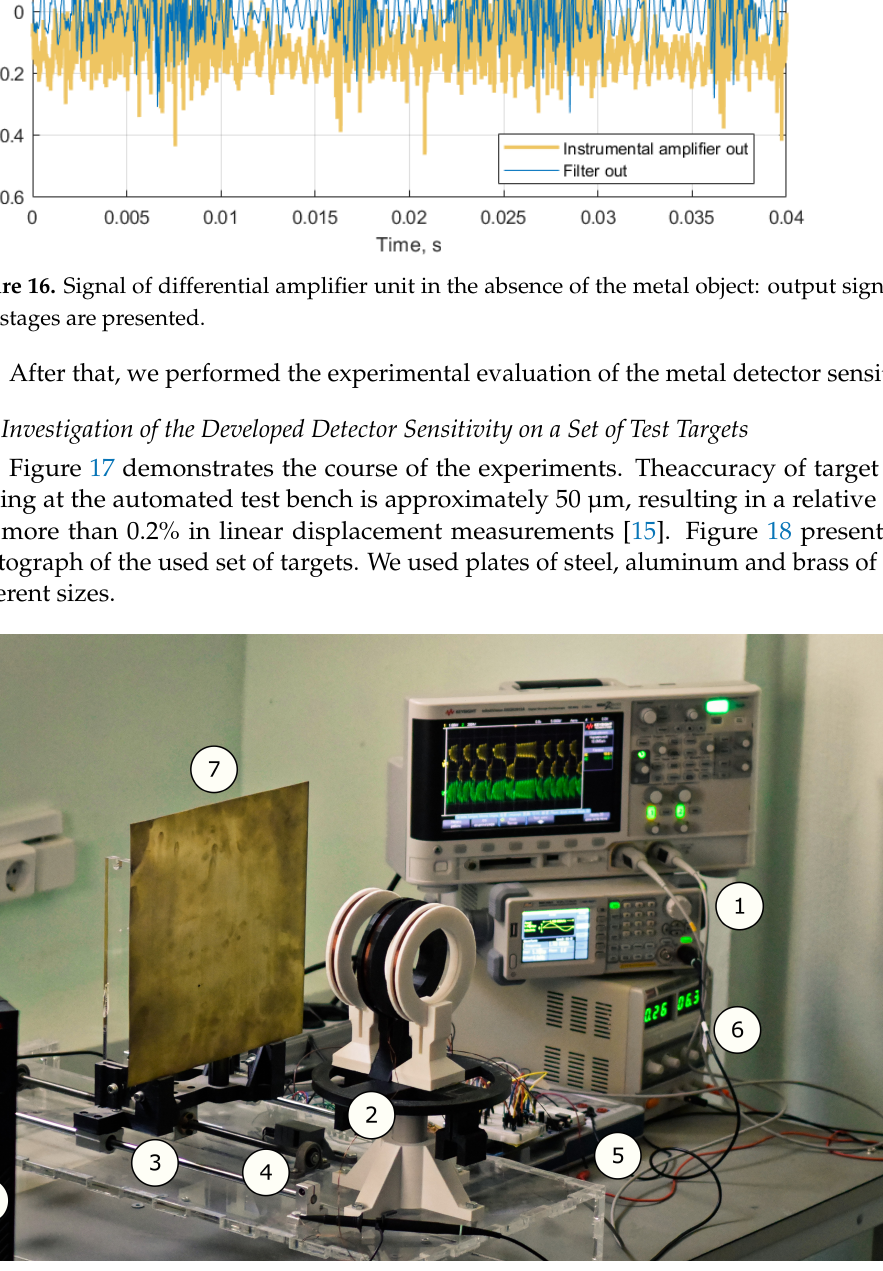
Figure 17. Determination of the largest detection distance by using an automated test bench. Here: (1) sine wave generator and the scope; (2) coils setup; (3) moving cart with the target mounted on it; (4) null position optical sensor; (5) NI ELVIS III device for interfacing and powering the metal detector circuitry and the bench; (6) power supply of the stepper motor of the bench; (7) the targe –square copper plate with 25 cm edge; and (8) personal computer for data acquisition and